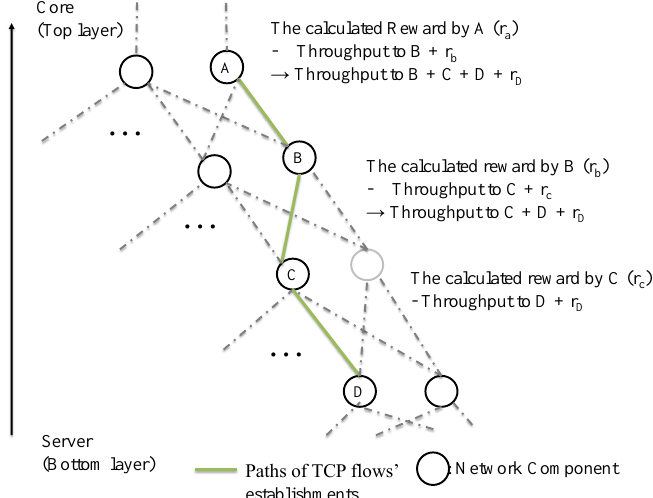
Figure 4. The abstraction of the reward feedback process (Hierarchical reward